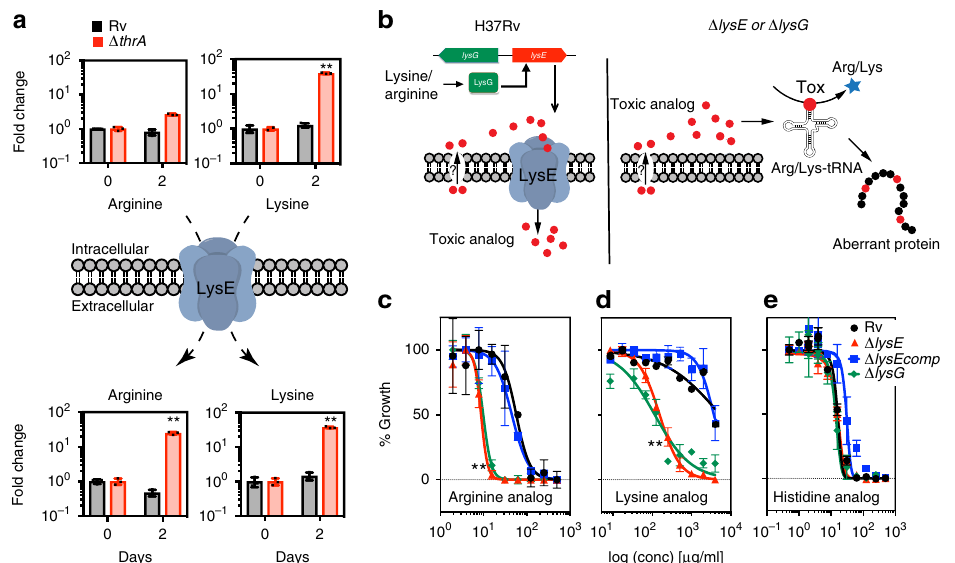
Fig. 5 Lysine and arginine are exported via the lysine permease LysE. a Accumulation of arginine and lysine in the supernatant of Mtb Δ thrA , indicated that Mtb harbors a lysine/arginine permease LysE. Rv1986 was identi fi ed bioinformatically as a LysE homolog and Rv1985c as its regulator LysG 19 . Both genes were individually deleted from Mtb H37Rv to yield strains Δ lysE and Δ lysG (Supplementary Table 1) and Δ lysE was complemented with a plasmid containing lysE under its native promoter yielding strain Δ lysEcomp . b Illustration of how inactivation of LysE leads to hypersusceptibility to toxic analogs. c , d , e Exporter speci fi city for lysine and arginine was tested by MIC experiments on Mtb H37Rv (green), Mtb Δ lysE (blue) , Mtb Δ lysEcomp (black) and Mtb Δ lysG (red) using toxic analogs of c arginine (canavanine), d lysine (2,6-diaminohex-4-ynoic acid and) and e histidine (ß-(2-Thiazolyl-DL-alanine). Mtb Δ lysE and Δ lysG are both hypersusceptible to toxic analogs of lysine and arginine but not histidine. All values are the average of three biological replicates ( n = 3) ± s.d. (error bars depict standard deviation) and are representative of a minimum of two independent experiments. ** p -value <0.01 in Student's t -test. Bars are overlaid with dot plot of individual values. Source data are provided as a Source Data fi